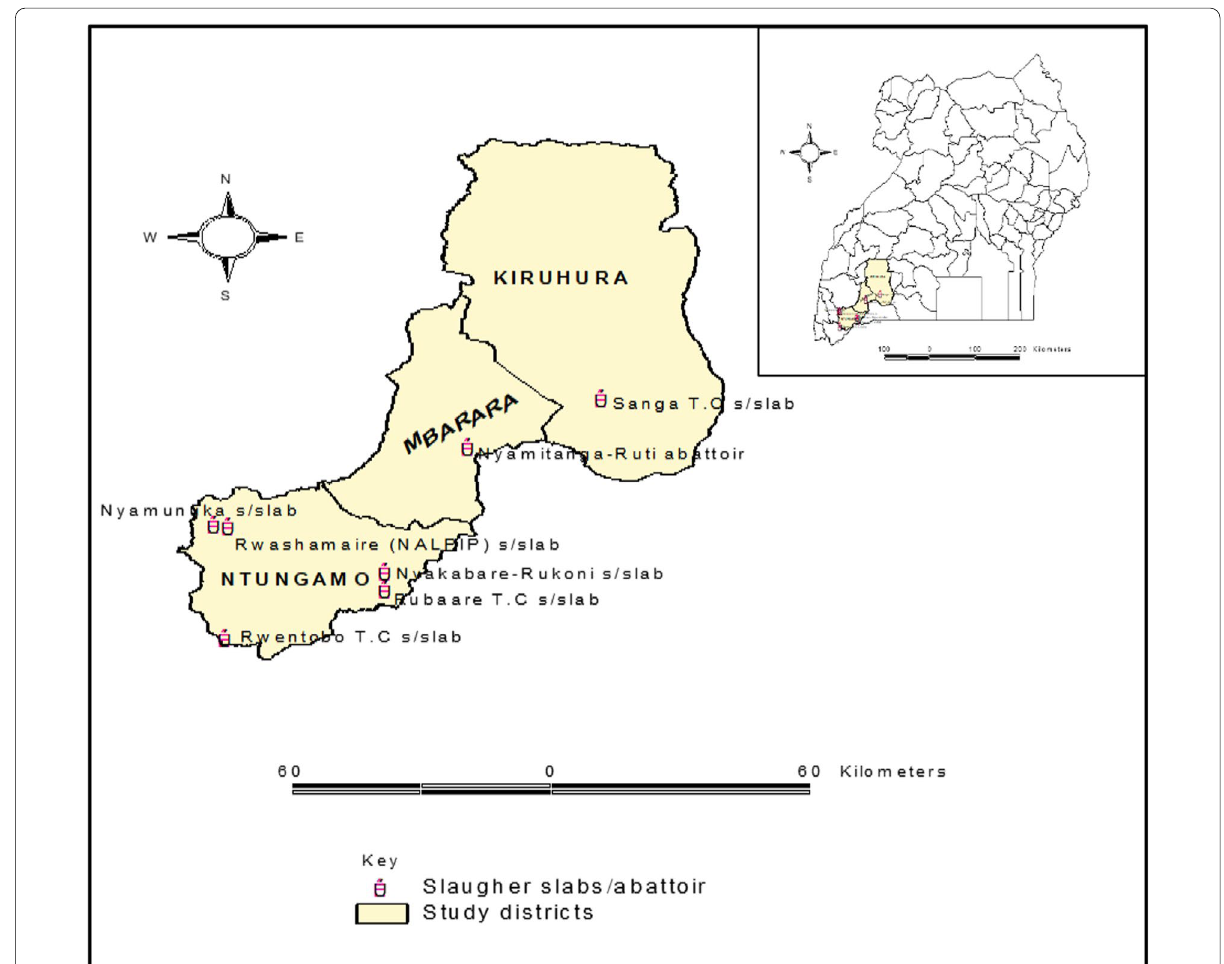
Fig. 1 Map showing the location of the study sites (slaughter slabs/abattoirs) in Ntungamo, Mbarara and Kiruhura districts. Inset is the map of Uganda showing the location of the selected districts